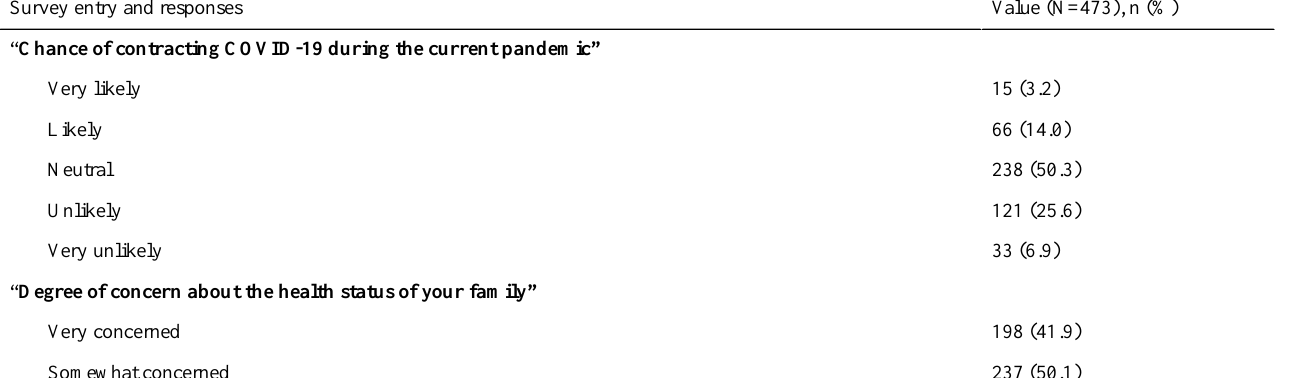
Table 2. Results of the COVID-19-related survey